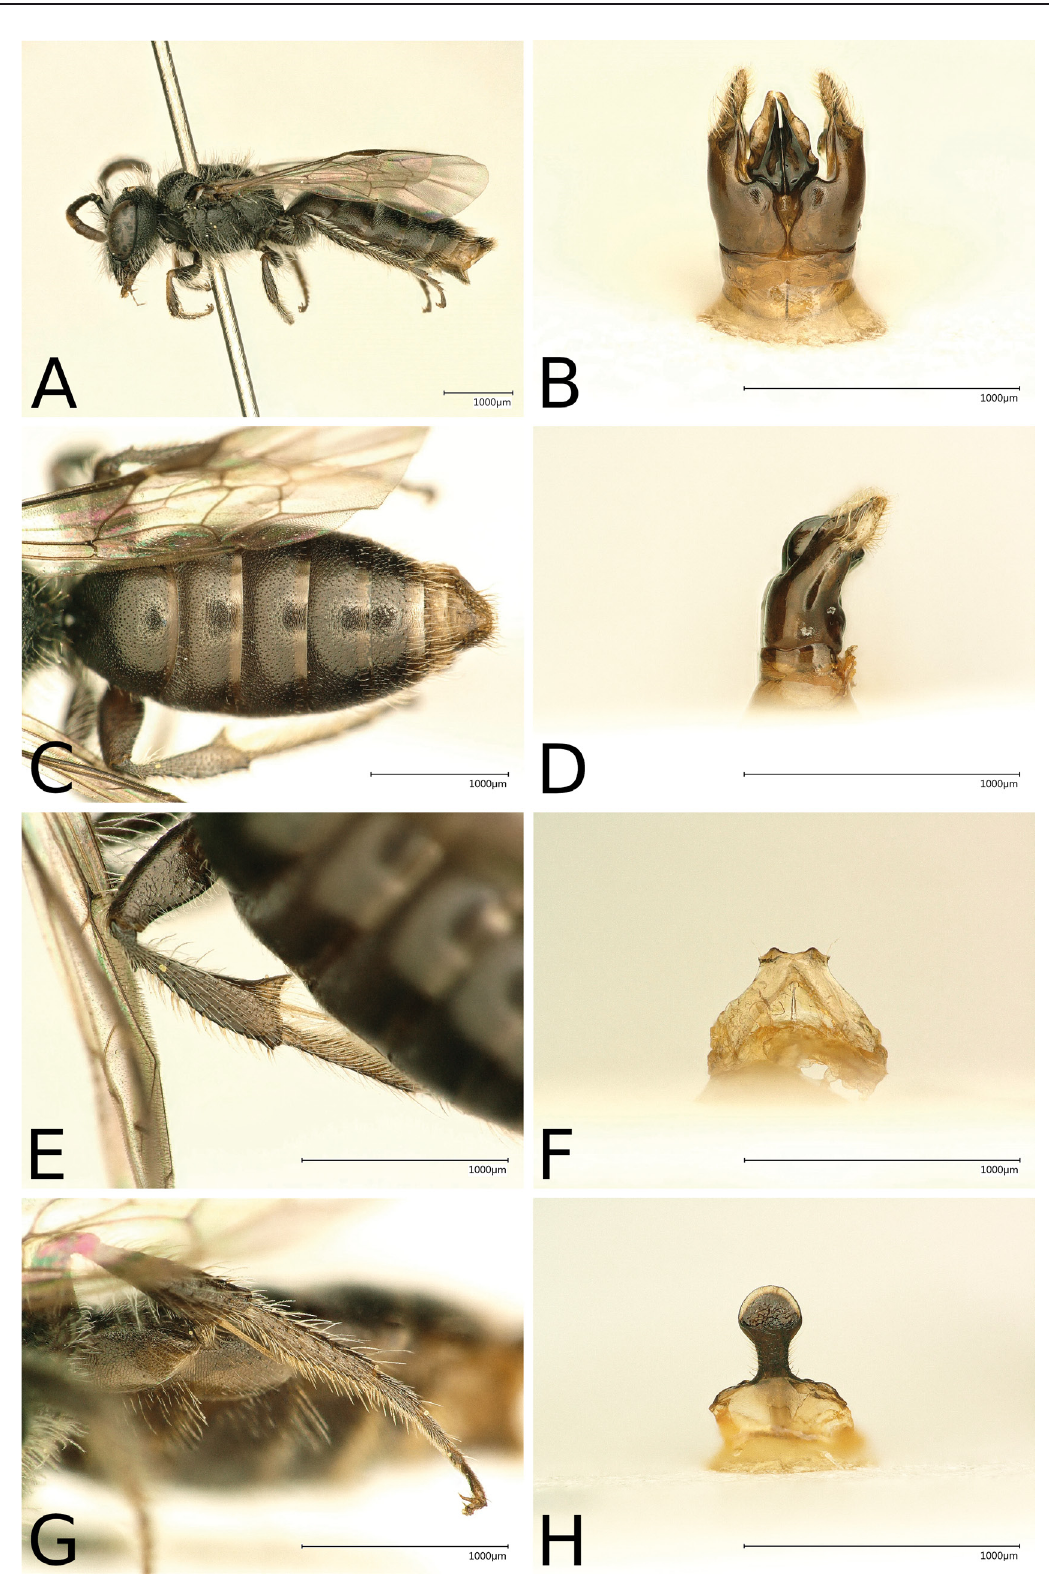
Fig. 7. Scrapter mellonholgeri Kuhlmann sp. nov., ♂, holotype (RCMK). A . Lateral view. B . Genitalia (dorsal view). C . Metasoma (dorsal view). D . Genitalia (lateral view). E . Hind tibia. F . S7 (dorsal view). G . Hind basitarsus. H . S8, apical